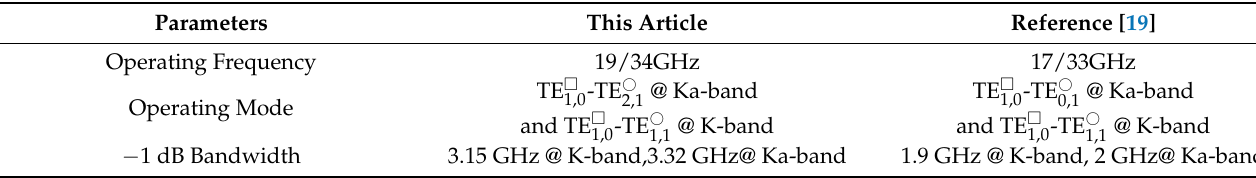
Table 2. The dual-band input coupler parameters.